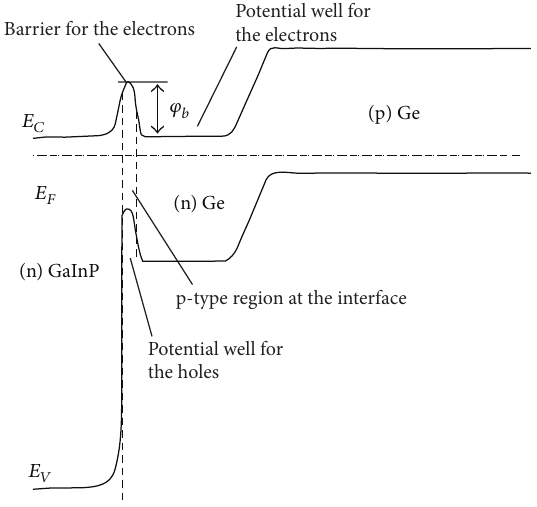
Figure 11: Schematic band diagram at equilibrium proposed for Ge “subcell” structures.